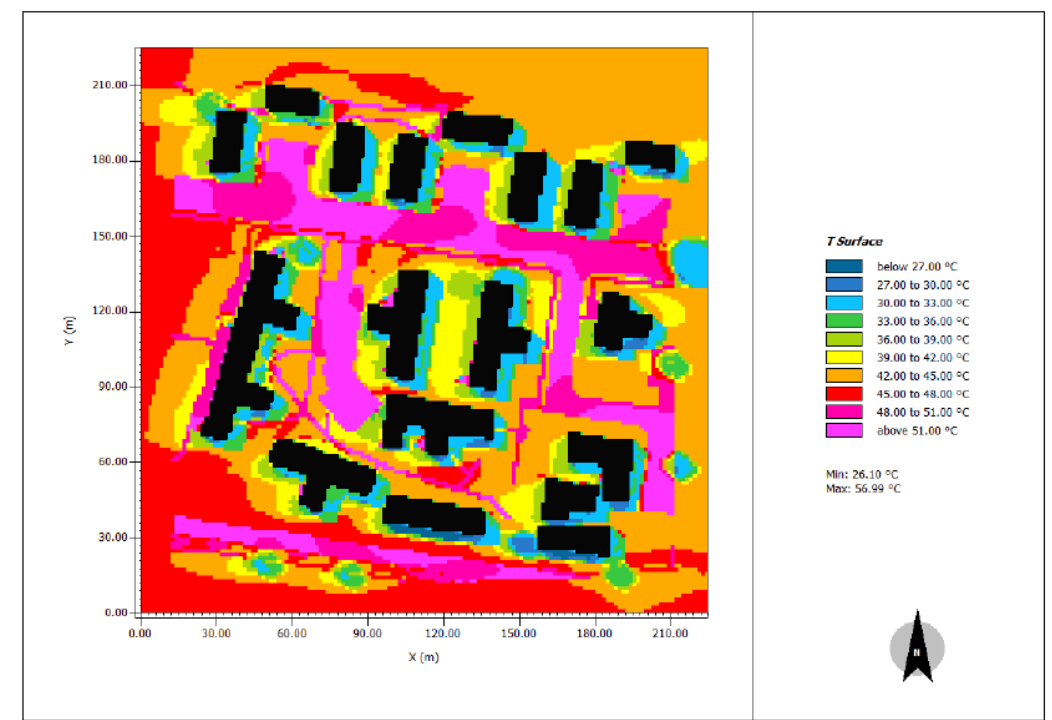
Figure 4. The surface temperature under unmitigated conditions for OT2 at 14:00.